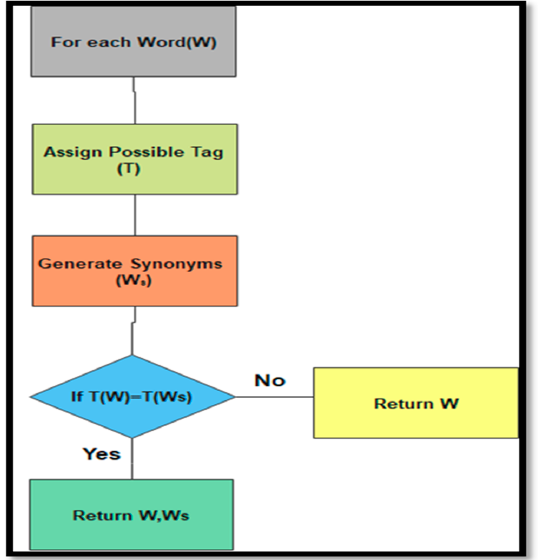
Figure 9. The shrinking method of the synonyms sets.